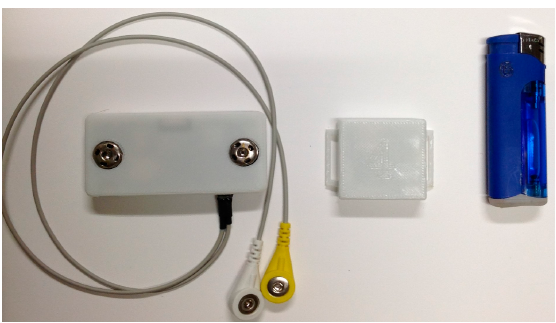
Figure 1. Chest module ( left ), hand module ( middle ), and instrumented lighter ( right ).